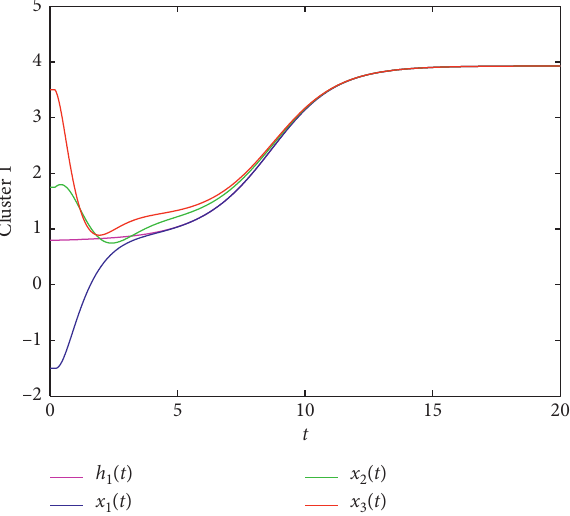
Figure 7: The trajectories of state changes in cluster 1.